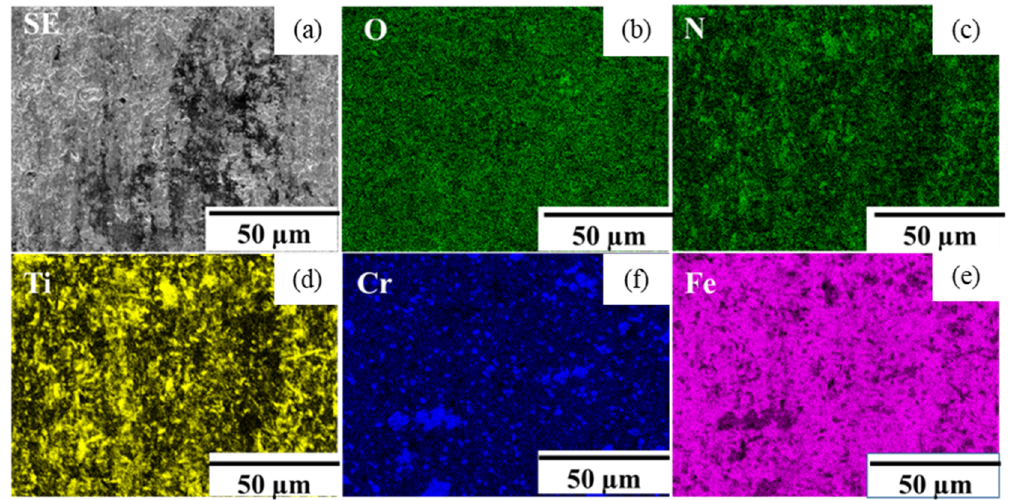
Figure 13. SEM image and element mapping at the center of the contact interface between the pure titanium and the Ns-SKD11 punch after continuously forging 20 times with r = 50%. ( a ) SE image, ( b ) Oxide (O) , ( c ) Nitride (N) , ( d ) Titanium (Ti) , ( e ) Chromium (Cr) , ( f ) Iron ( Fe)